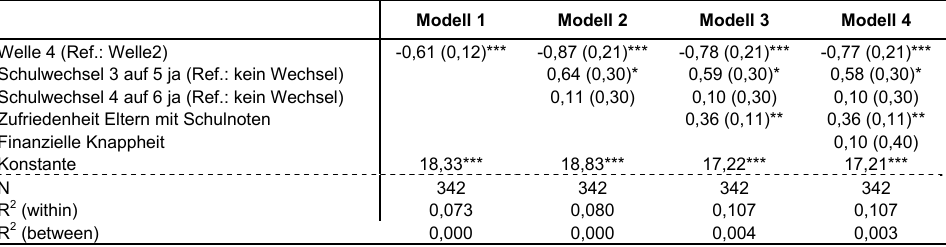
Tabelle 3 : Zwei-Wellen-Panelregressionsmodell (fixed-effects) des elterlichen Schulinteresses auf zentrale zeitveränderliche Einflussfaktoren Modell 1 Modell 2 Modell 3 Modell